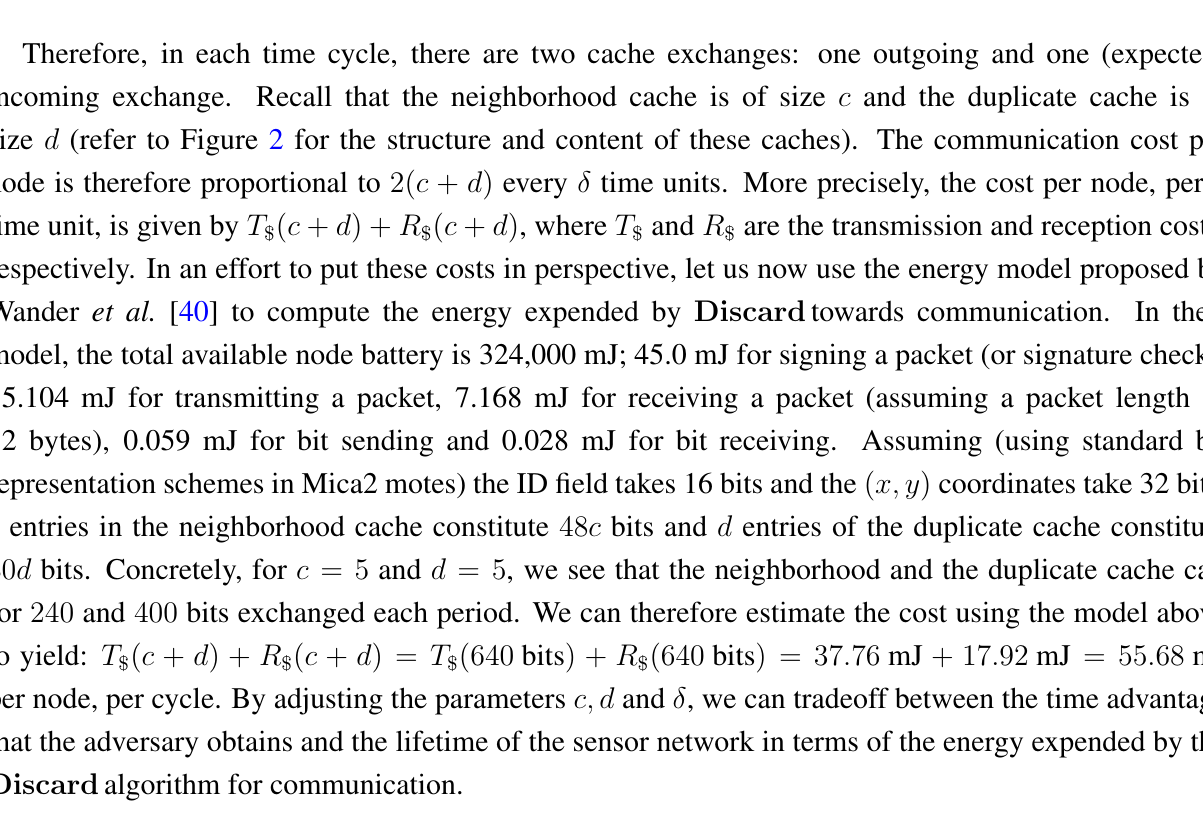
Figure 4. Number of incoming cache exchange requests per cycle, per